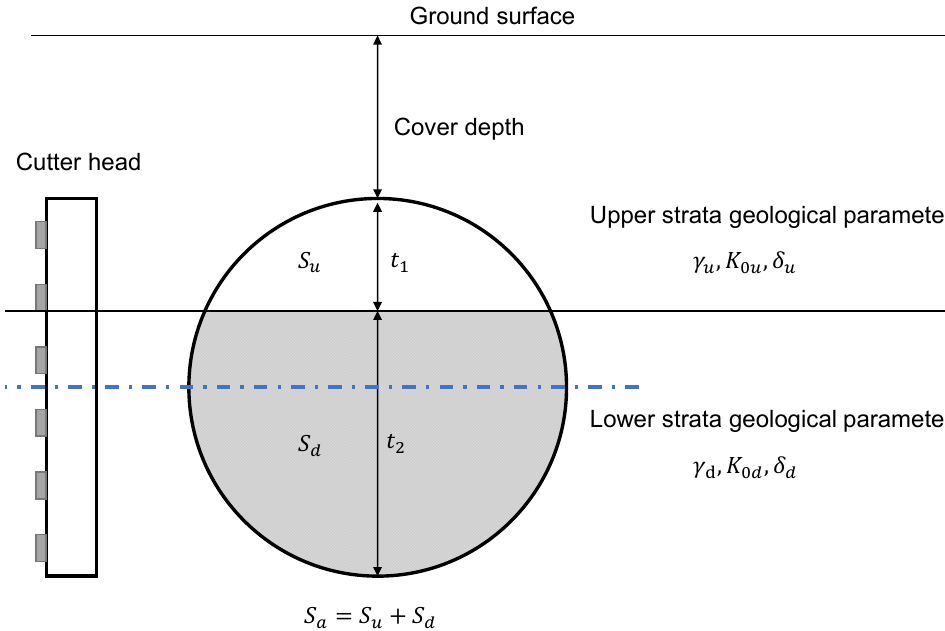
Figure 3. Diagram of mixed ground. ( γ , K 0 , and δ are the geological parameters that will be introduced later. The dotted line represents the central axis of the shield tunneling).